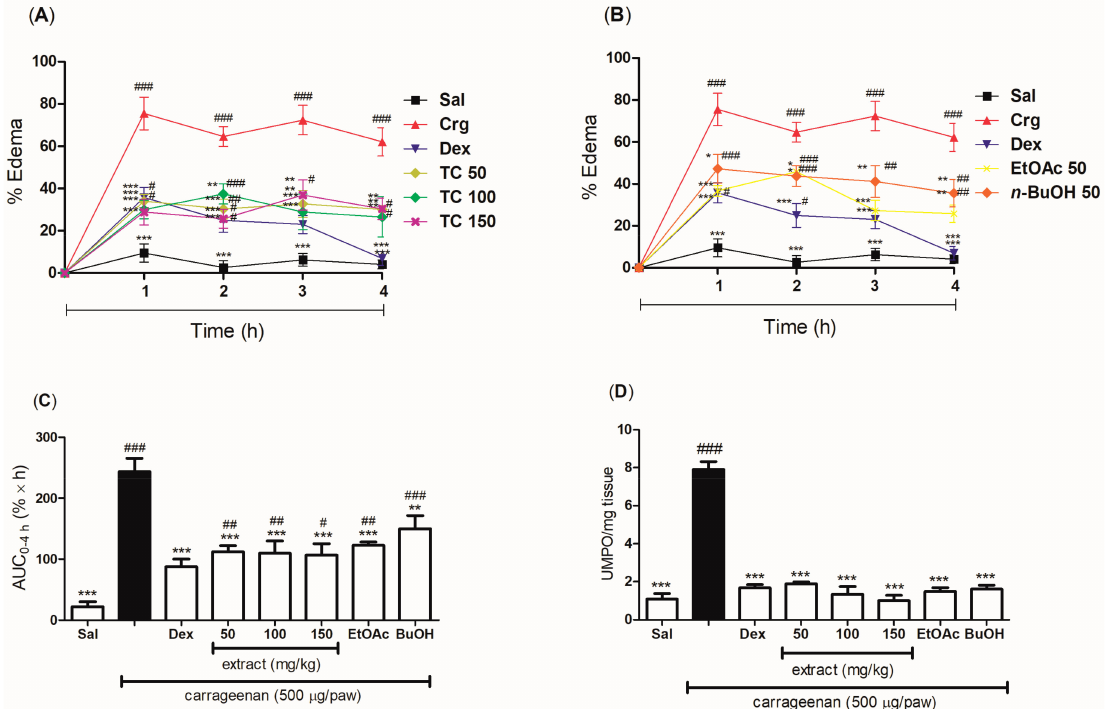
Figure 4. Evaluation of the anti-inflammatory effect of the post-treatment with the hydroethanolic extract and the ethyl acetate (EtOAc) and n -butanol (BuOH) fractions of T. catharinensis leaves in the carrageenan-induced paw edema model. BALB/c mice were treated orally with saline, the hydroethanolic extract at doses of 50, 100, or 150 mg/kg, the ethyl acetate (EtOAc) and n -butanol (BuOH) fractions at the dose of 50 mg/kg, and dexamethasone (2 mg/kg). The edema was measured at different time points (1, 2, 3, and 4 h) after the administration of λ -carrageenan (500 µ g/paw). After 4 h, the paw was removed and the enzymatic activity was measured. One unit of MPO activity (UMPO) was defined as one micromole of peroxide degraded per minute. ( A ) Percentage of edema (0–4 h) in mice post-treated with the hydroethanolic extract; ( B ) Percentage of edema (0–4 h) in mice post-treated with the EtOAc and BuOH fractions; ( C ) AUC of the percentage of edema as a function of time in hours (0–4 h) in mice post-treated with the hydroethanolic extract and the fractions; ( D ) MPO activity in the paws of mice post-treated with the hydroethanolic extract and the fractions. ### p < 0.001, ## p < 0.01 and # p < 0.05 compared with the group treated with saline; *** p < 0.001, ** p < 0.01, and * p < 0.05 compared with the carrageenan group. Sal: saline (0.9 mg/mL); Crg: carrageenan (500 µ g/paw); Dex: dexamethasone (2.0 mg/kg); TC 50: T. catharinensis extract (50 mg/kg); TC 100: T. catharinensis extract (100 mg/kg); TC 150: T. catharinensis extract (150 mg/kg); EtOAc 50: ethyl acetate fraction (50 mg/kg); BuOH 50: n -butanol fraction (50